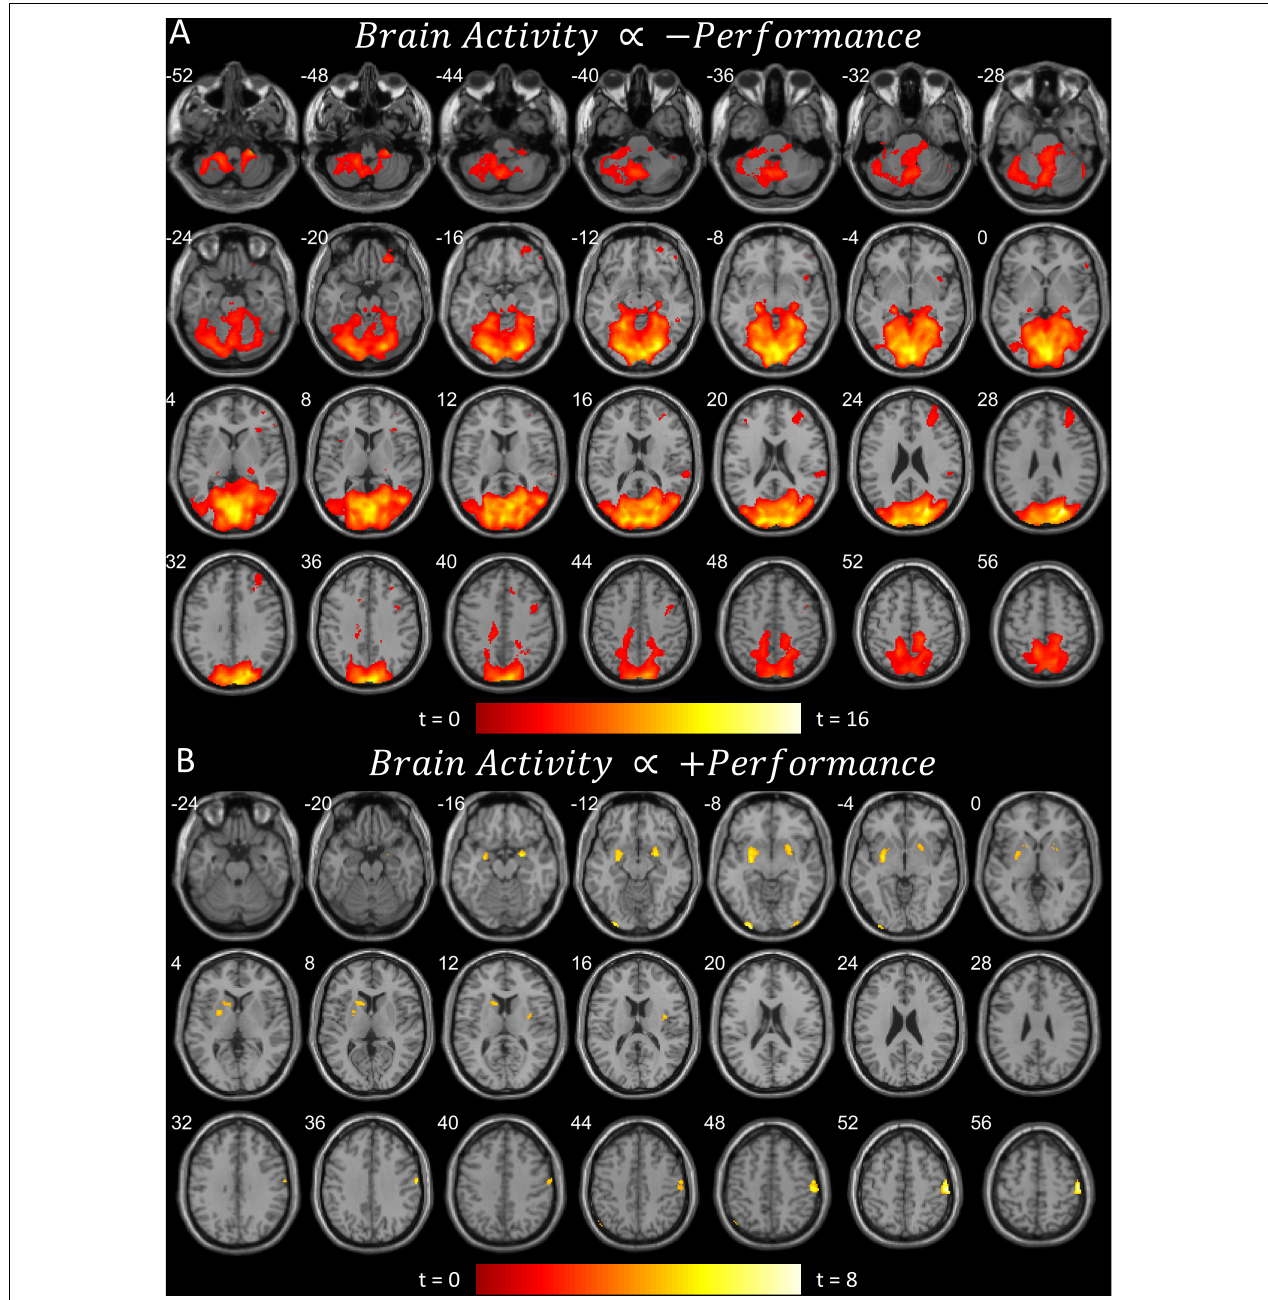
FIGURE 2 | (A) Brain areas that become more active when performance worsens, or less active when performance improves (pFDR < 0.05 peak level corrected across entire brain) rendered on anatomical MRI slices using xjView toolbox (https://www.alivelearn.net/xjview). Note cerebellar and cortical activity. (B) Brain